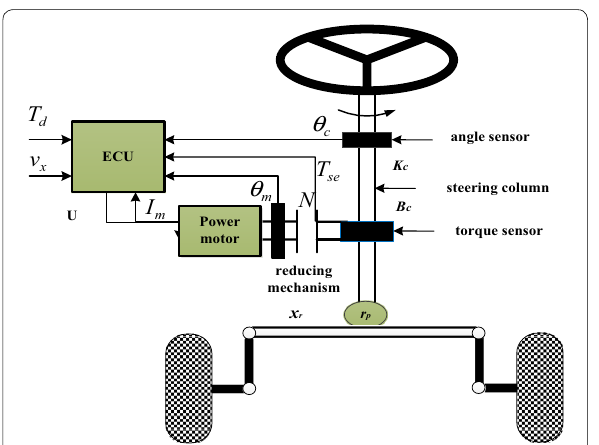
Figure 2 Structure of electric power steering (EPS)